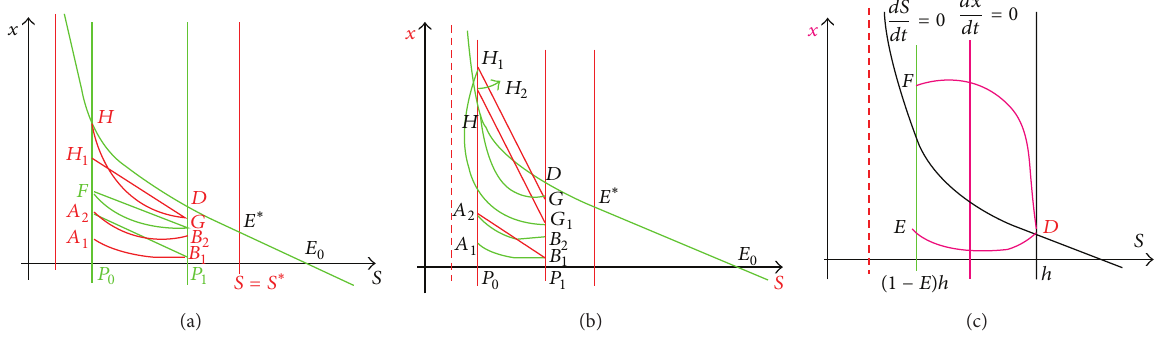
Figure 1: (a) and (b) The existence of order-1 periodic solution for ℎ < 𝑘𝐷/(𝜇 − 𝐷) . (c) The existence of order-1 or order-2 periodic solution for ℎ ≥ 𝑘𝐷/(𝜇 − 𝐷)